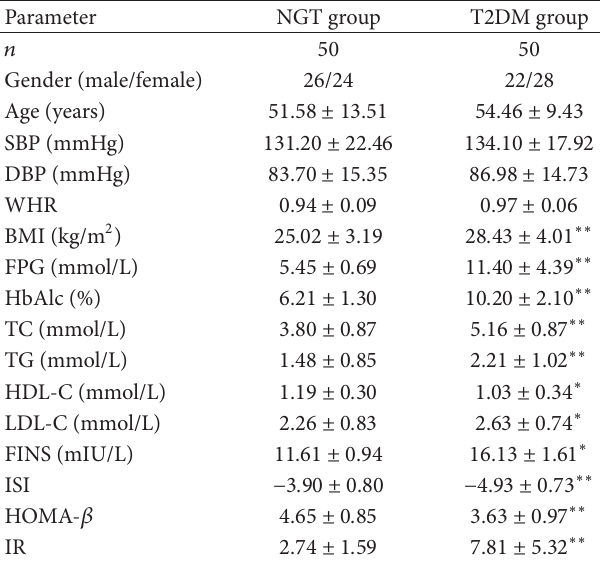
Table 1: Clinical and metabolic characteristics of Uyghurs between NGT and T2DM